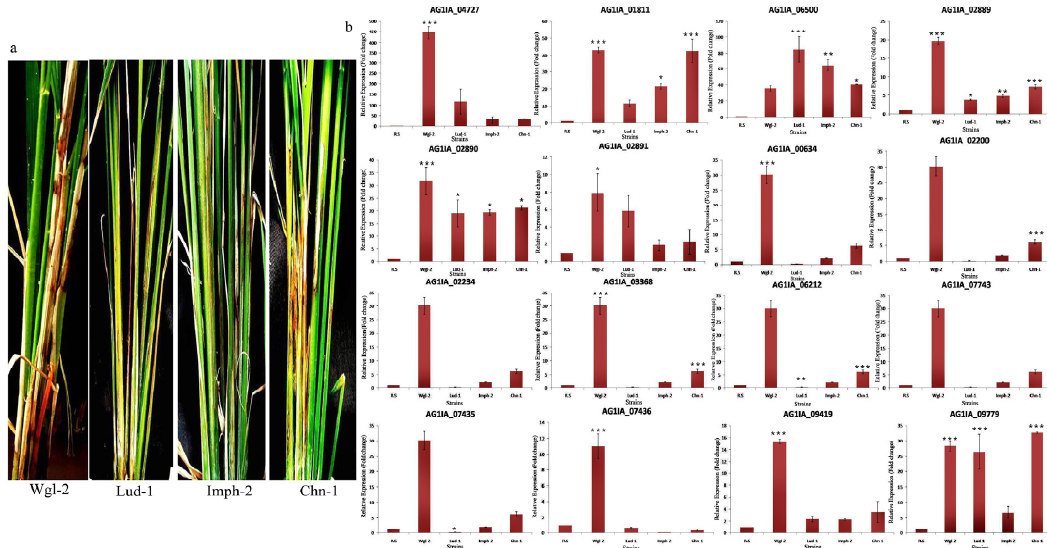
Figure 10. ( a ) The sheath blight disease symptoms on TN1 plants upon inoculation of di ff erent strains of R. solani . ( b ) qRT-PCR expression analysis of 16 PD genes (polygalacturonases and pectinesterases) in sheath tissue of TN1 after inoculation with di ff erent strains of R. solani . X-axis: samples (sheath tissue of TN1 inoculated with four di ff erent strains of R. solani ); Y-axis: Expression level of the individual PD genes relative to their expression in R. solani grown in PDA. Error bars indicate the mean ± S.E. of three biological replicates. Statistical significance was determined by performing one-way ANOVA analyses followed by a Tukey’s test (* = p < 0.01, ** = p < 0.001, and *** = p < 0.0001).